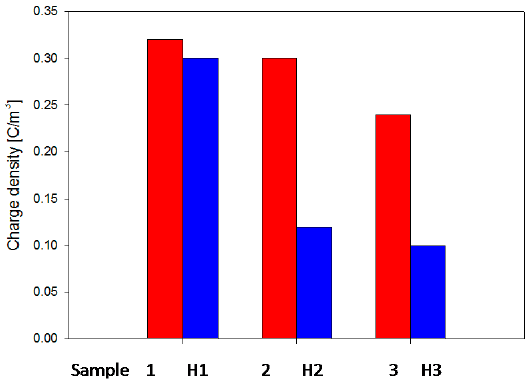
Figure 31. Space charge distribution at 20 kV/mm in unfilled and filled XLPE (samples 1, 2 and 3) before and after treatment (samples H1, H2 and H3) at 80 °C for five days (© 2016 IEEE. Reprinted, with permission, from [24]).